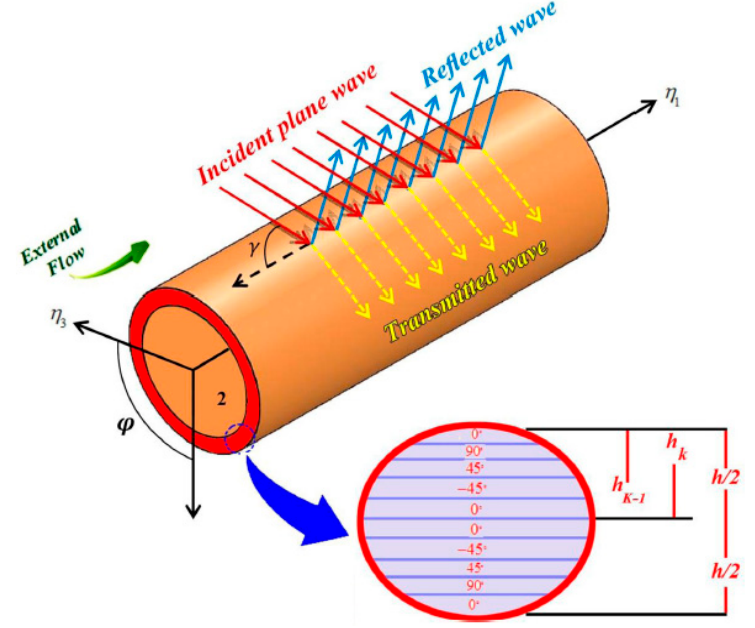
Figure 6. Schematic representation of sandwich composite cylindrical shell [69] (reproduced with permission from Talebitooti et al. Composite Structures; published by Elsevier, 2016).